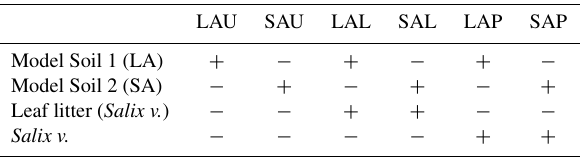
Table 2. Overview of treatments in the flooding–drying experiment. Model Soil 1, containing soil macroaggregates is abbreviated LA, whereas Model Soil 2 contains soil microaggregates and is abbre- viated SA. The last character of each abbreviation stands for una- mended (U), litter addition (L) or plant presence (P). Each treatment was replicated six